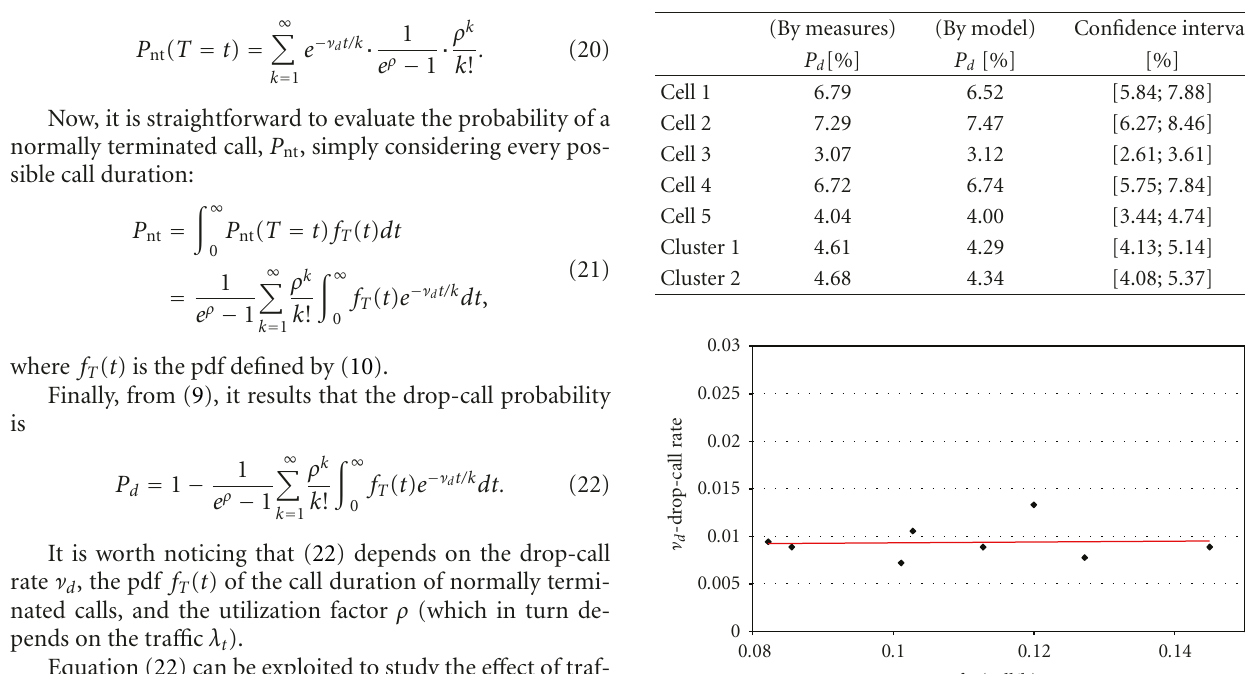
Samples of ν d vs. λ t Least mean square linear fitting Figure 10: Total entering tra ffi c in a cell, λ t , versus the drop-call rate, ν d